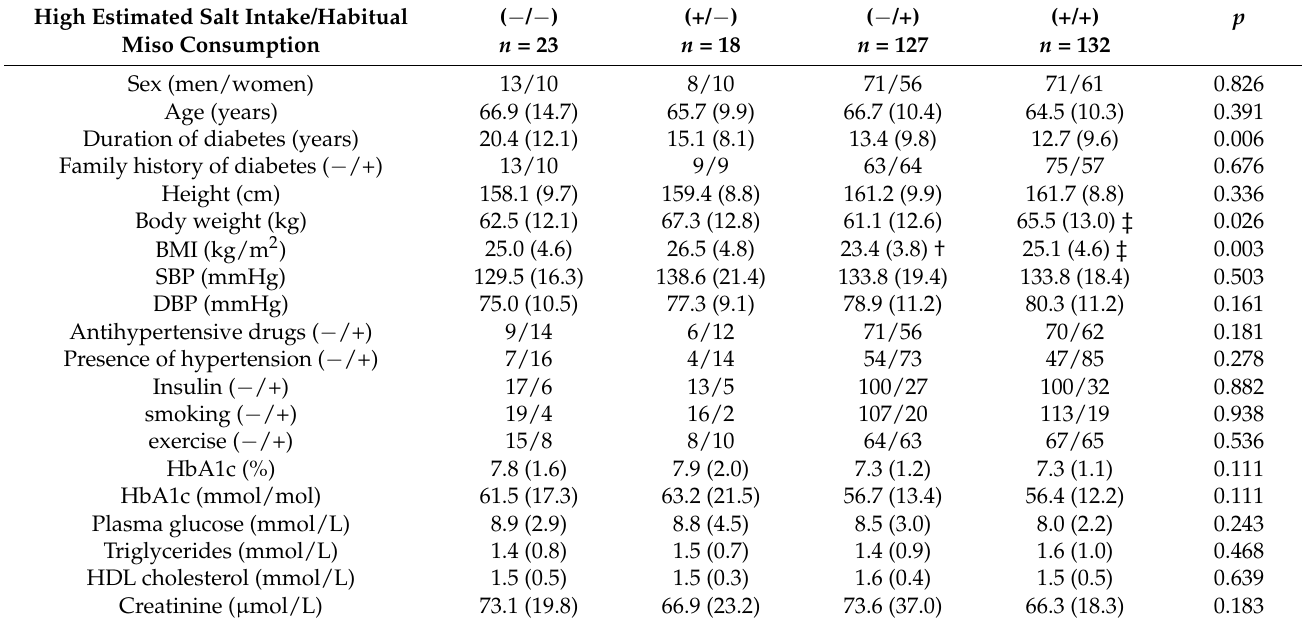
Table 2. Clinical characteristics of study participants according to the presence or absence of high estimated salt intake or habitual miso